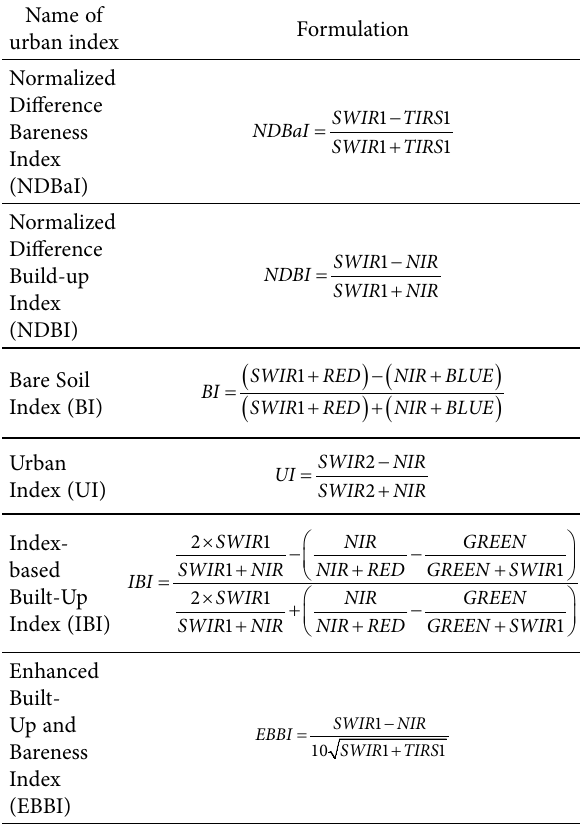
Table 2. Extracted urban indices form Landsat 8 imagery Name of